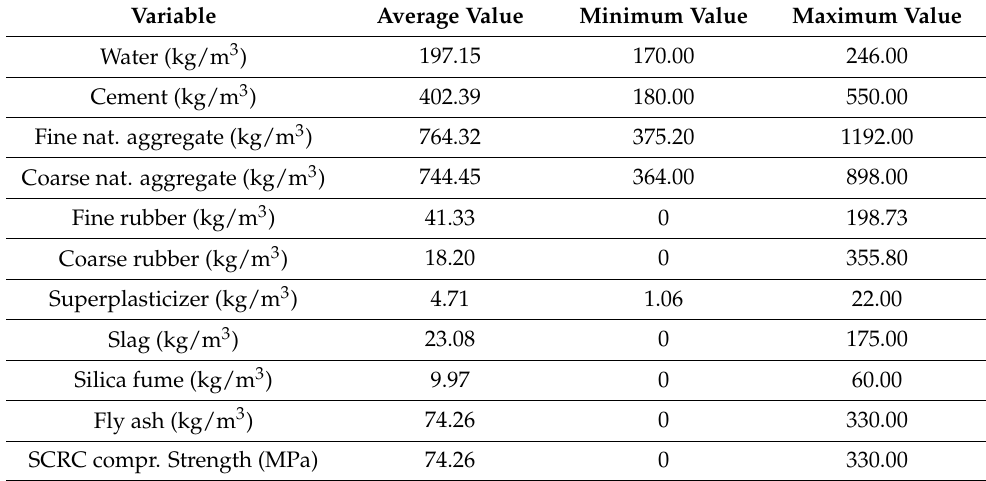
Table 2. Average, minimum and maximum values of input and output variables used for